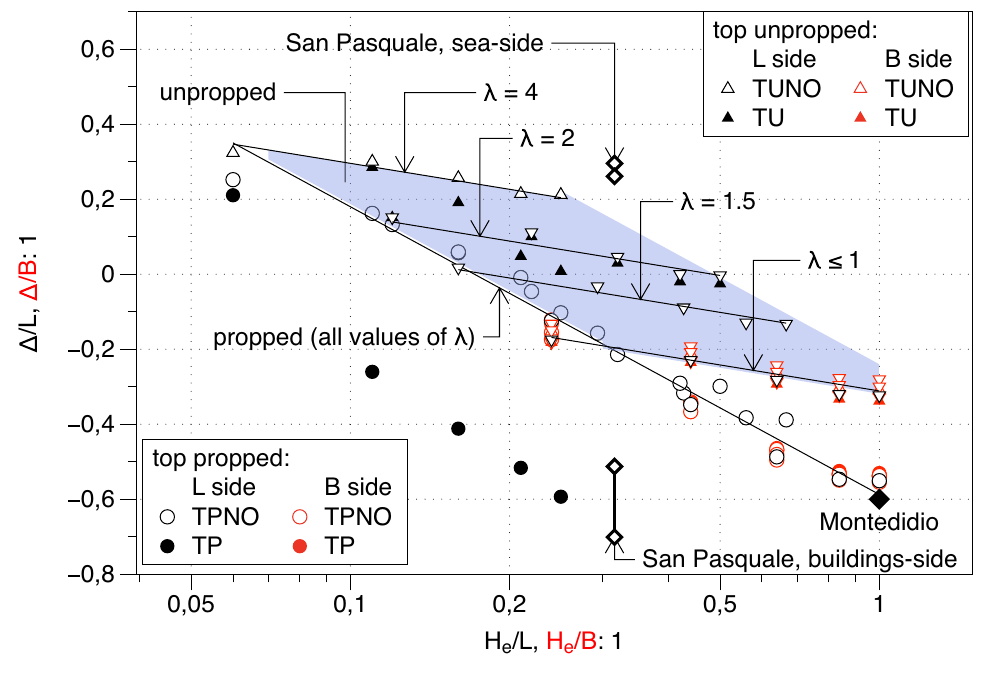
Figure 19. Normalised plateau length Δ/L (Δ/B).